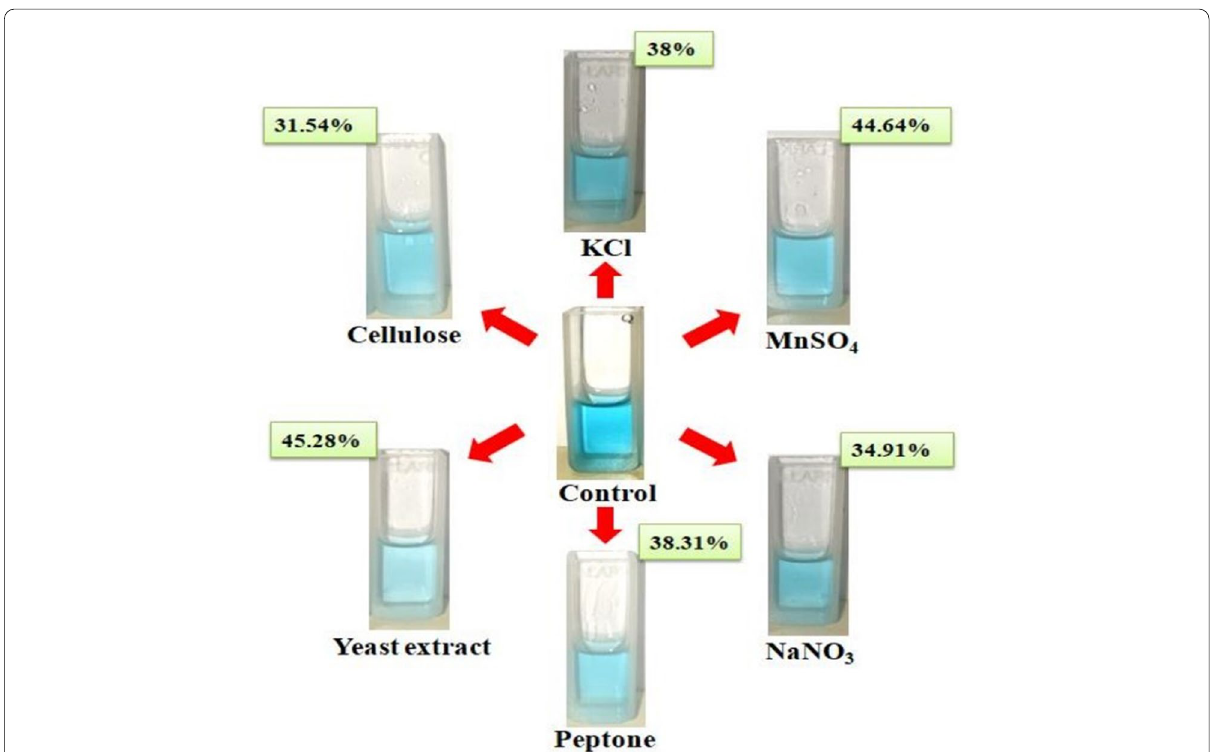
Fig. 7 Dye-decolourization pattern for the enzyme LiP from Bacillus mycoides cultured in different enriched media supplemented with cellulose, KCl, MnSO 4 , peptone, NaNO 3 , and yeast extract. The percentage values indicate degree of dye decolourization in respective enriched media supplemented with specific carbon, nitrone, and meal ion